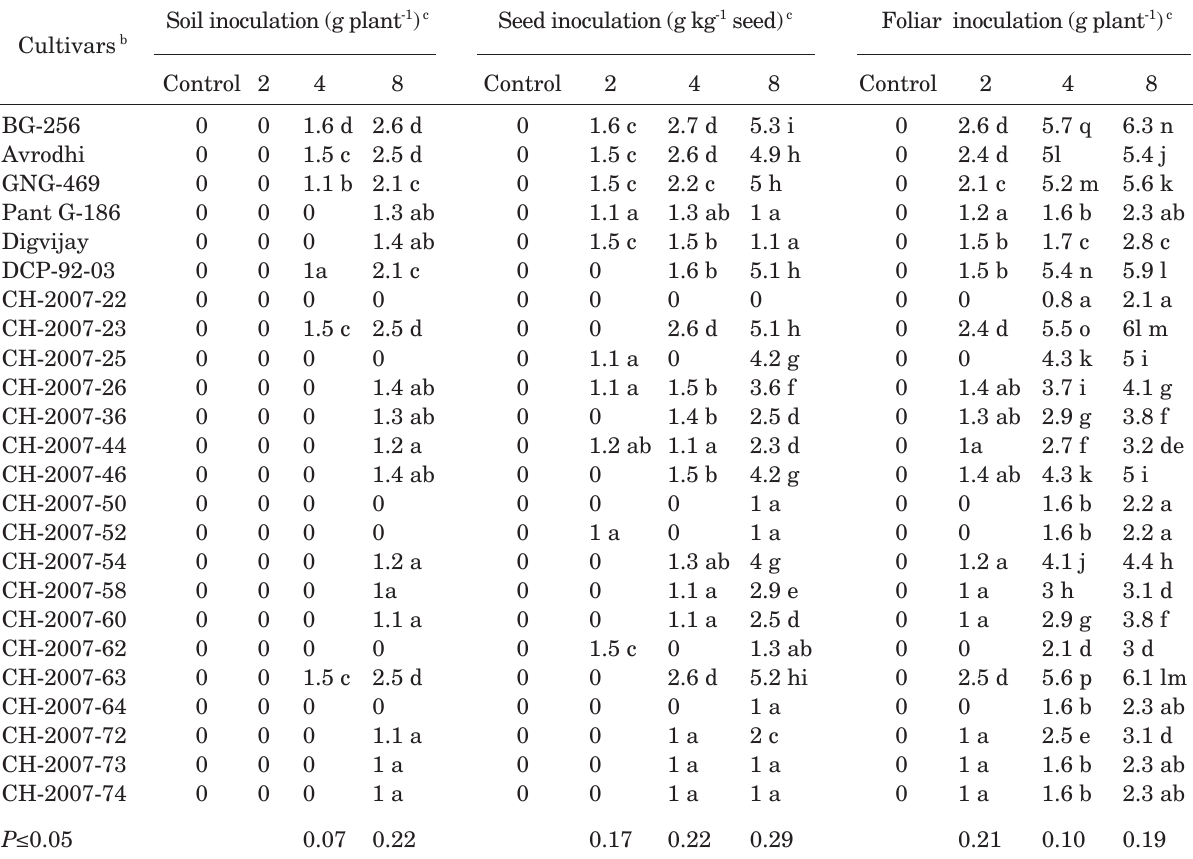
Table 1. Disease severity (0–10 scale) a of chickpea cultivars with soil, seed and foliar inoculation of Botrytis cinerea. Soil inoculation (g plant -1 ) Cultivars b